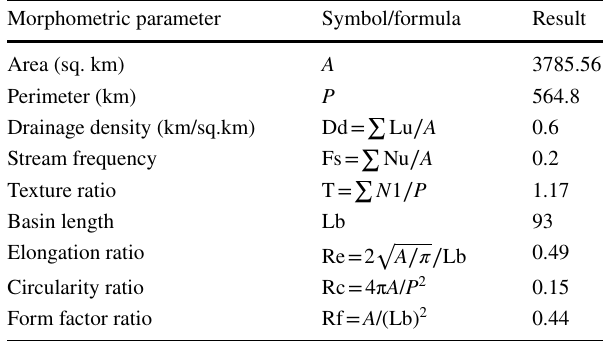
Table 2 Arial aspects of the study area